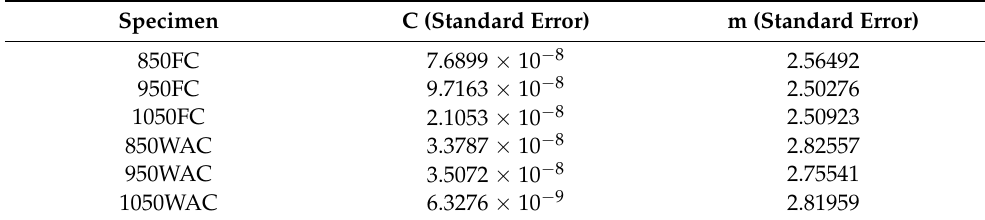
Table 3. Paris constants for different